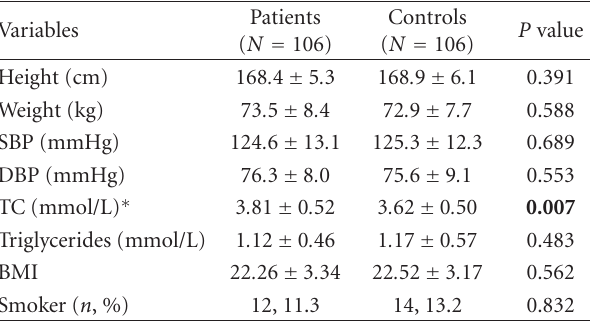
Table 1: Baseline characteristics of